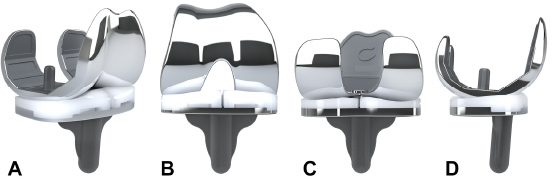
Figure 1. Representative images of the patient-specific, cruciate-retaining iTotal CR G2 total knee replacement. ( A ) Antero-medial, ( B ) anterior, ( C ) posterior, and ( D ) lateral view of the device. Please note that the medial and lateral polyethylene inserts have different heights that correspond to the condylar offset of the femur.